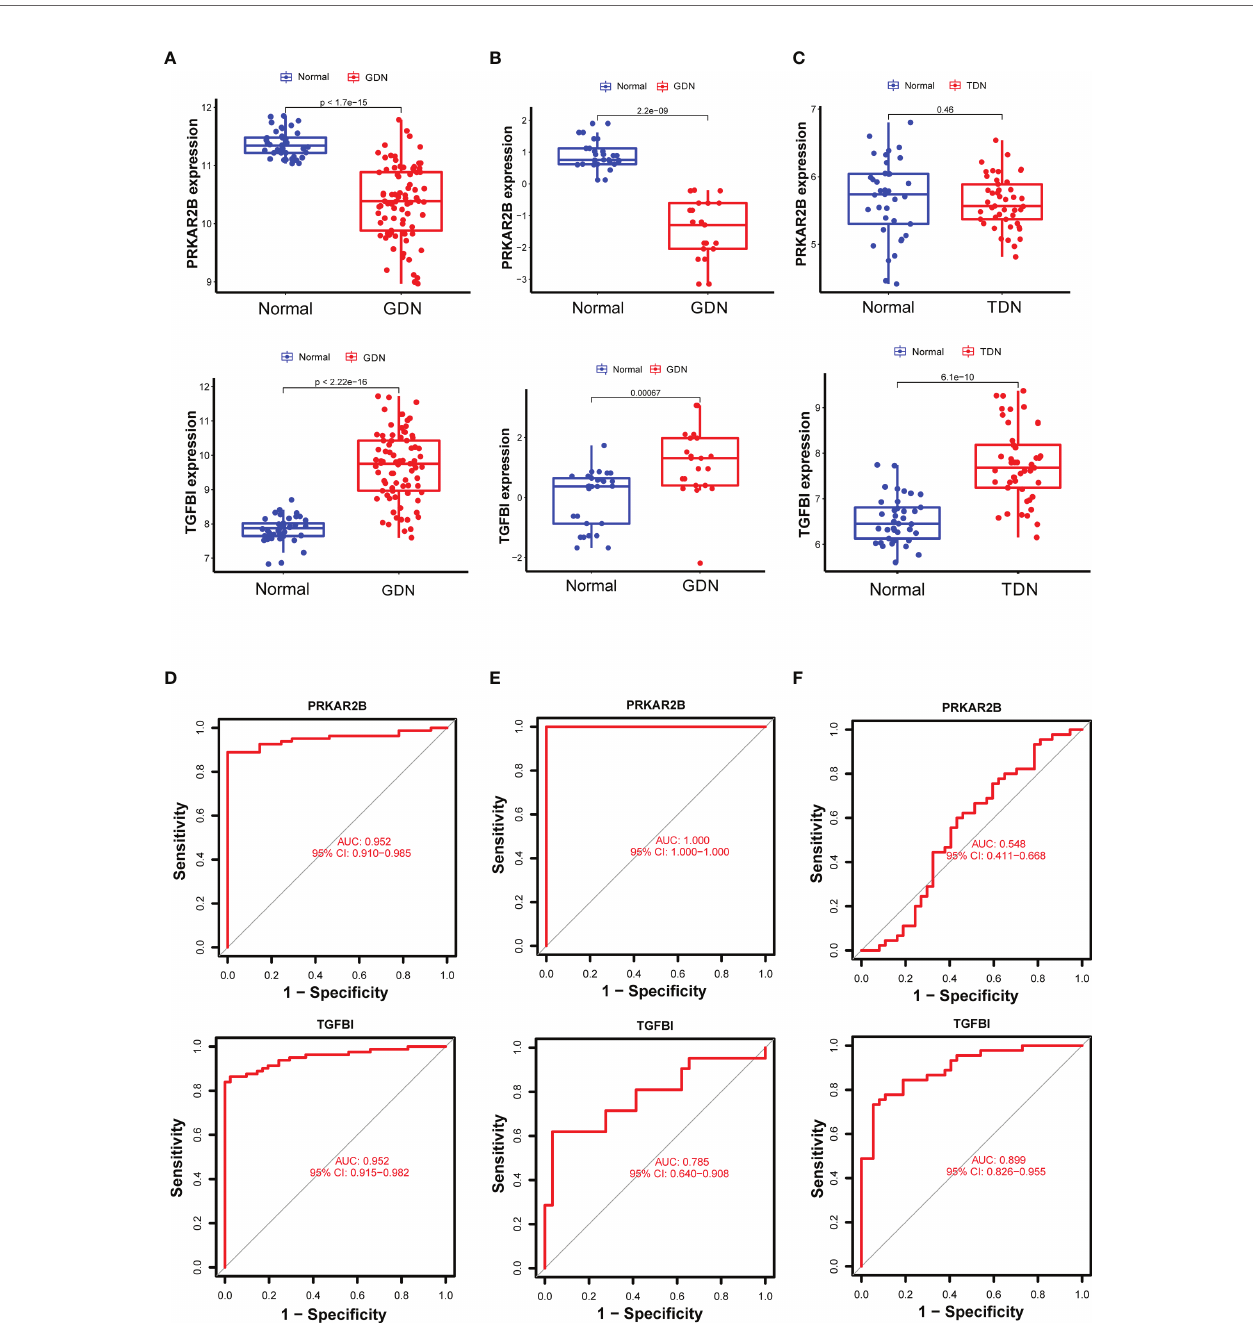
FIGURE 4 | Veri fi cation of the identi fi ed biomarkers. (A – C) Box plots for the differential expression analysis in the GDN training cohort, GDN testing cohort, and TDN testing cohort, respectively. (D – F) ROC curves for evaluating the diagnostic ability in the GDN training cohort, GDN testing cohort, and TDN testing cohort, respectively. p < 0.05 was considered statistically signi fi